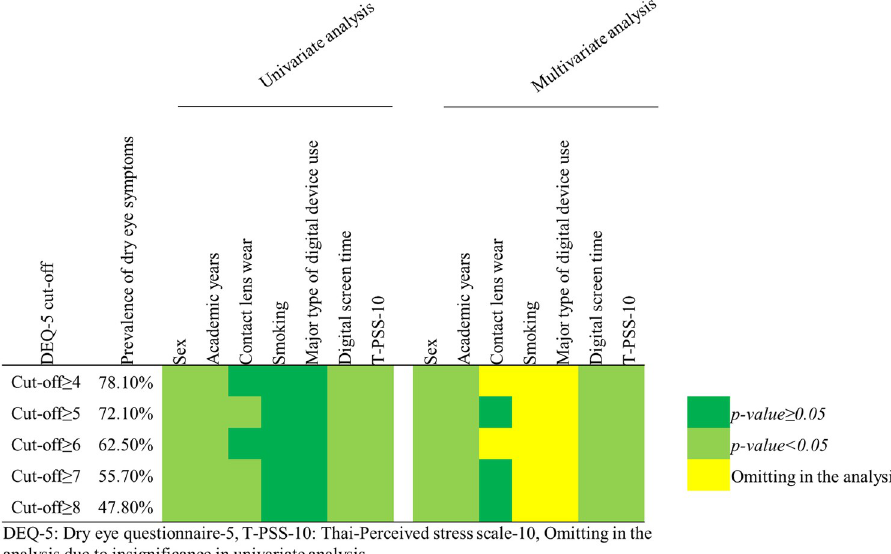
Fig 2. The prevalence and associated factors of symptomatic dry eye classified using different 5-item dry eye questionnaire (DEQ-5) cut-off scores. The associated factors were computed by univariate and multivariate logistic regression. The yellow color indicated omissions in the analysis, green color indicated p -values � 0.05 and light green color indicated p -values < 0.05.